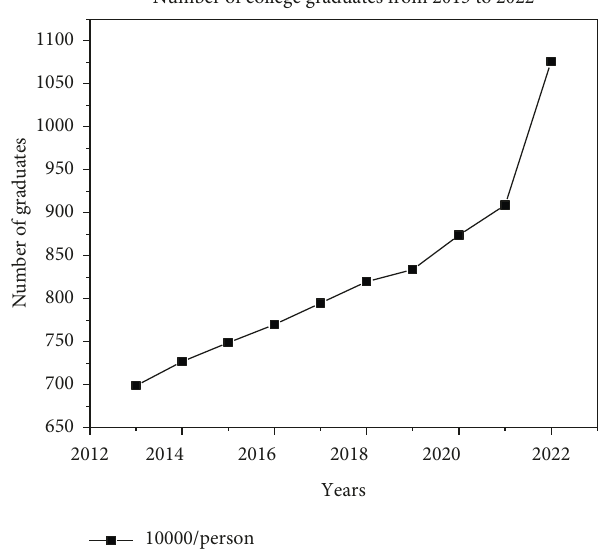
Figure 2: Number of college